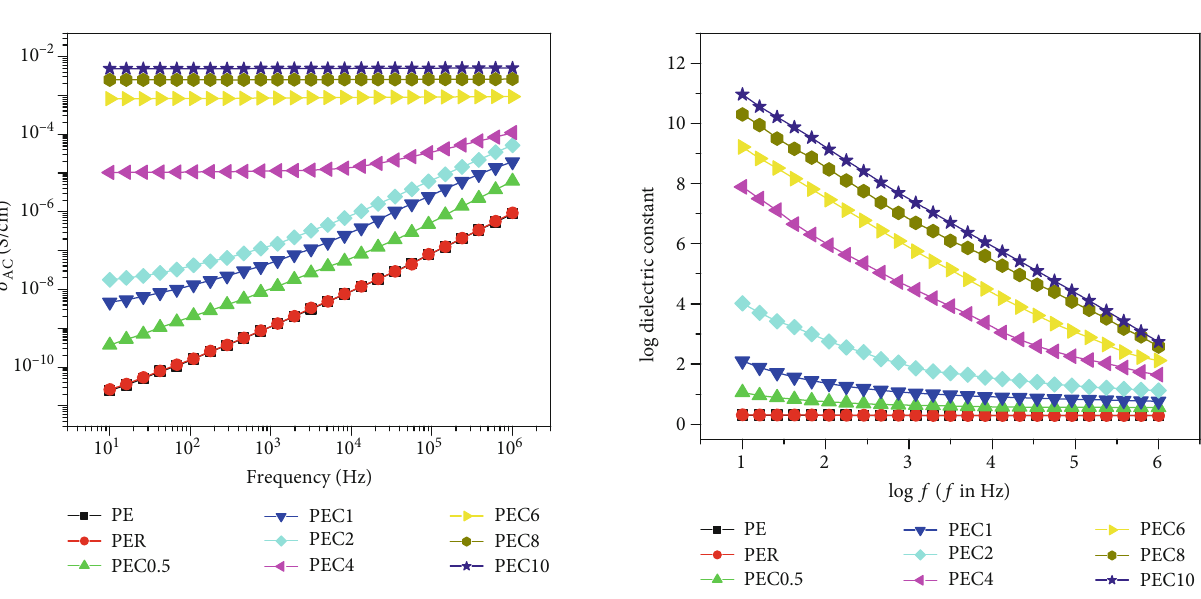
Figure 7: Plots of the dielectric constant with respect to frequency for the composite